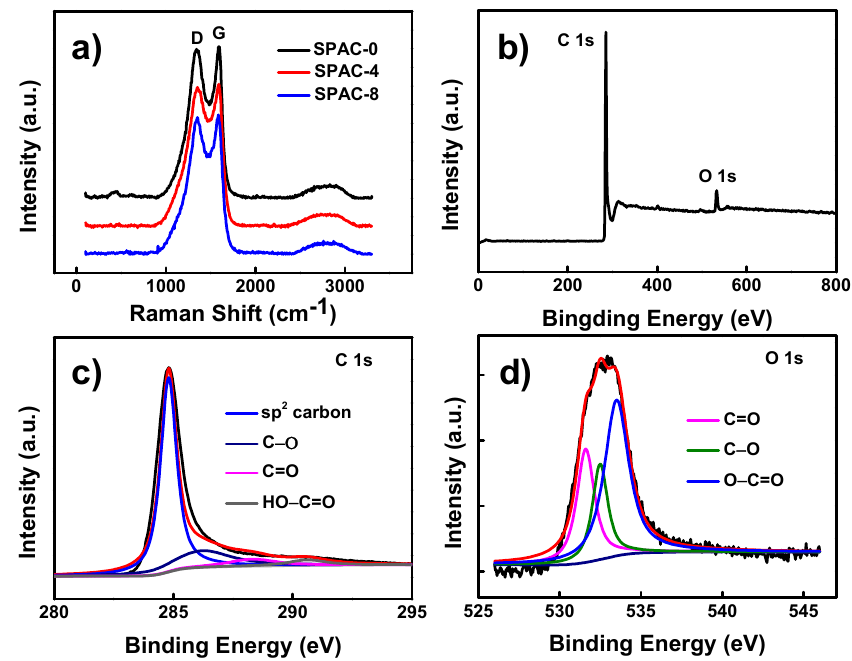
Figure 3. Raman spectra of SPAC-0, SPAC-4 and SPAC-8 ( a ), survey XPS spectra of SPAC-8 ( b ), and high-resolution C 1s spectra ( c ), high-resolution O 1s spectra ( d ) of SPAC-8.